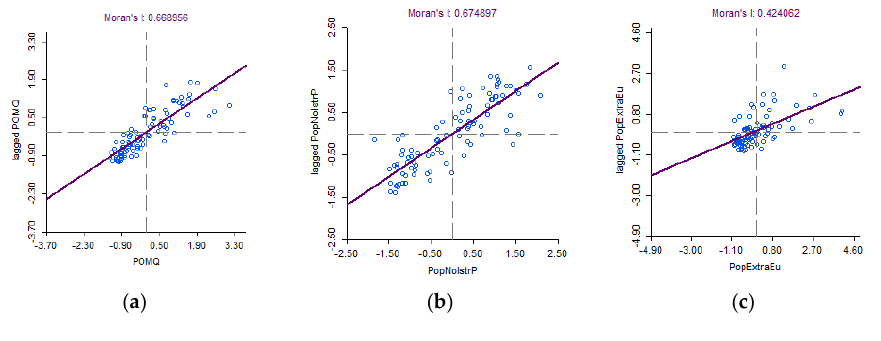
Figure 5. Moran’s I and Moran Scatter plots: ( a ) LP mean; ( b ) LEPI; ( c ) FPI. (Source: Authors’ elaboration).